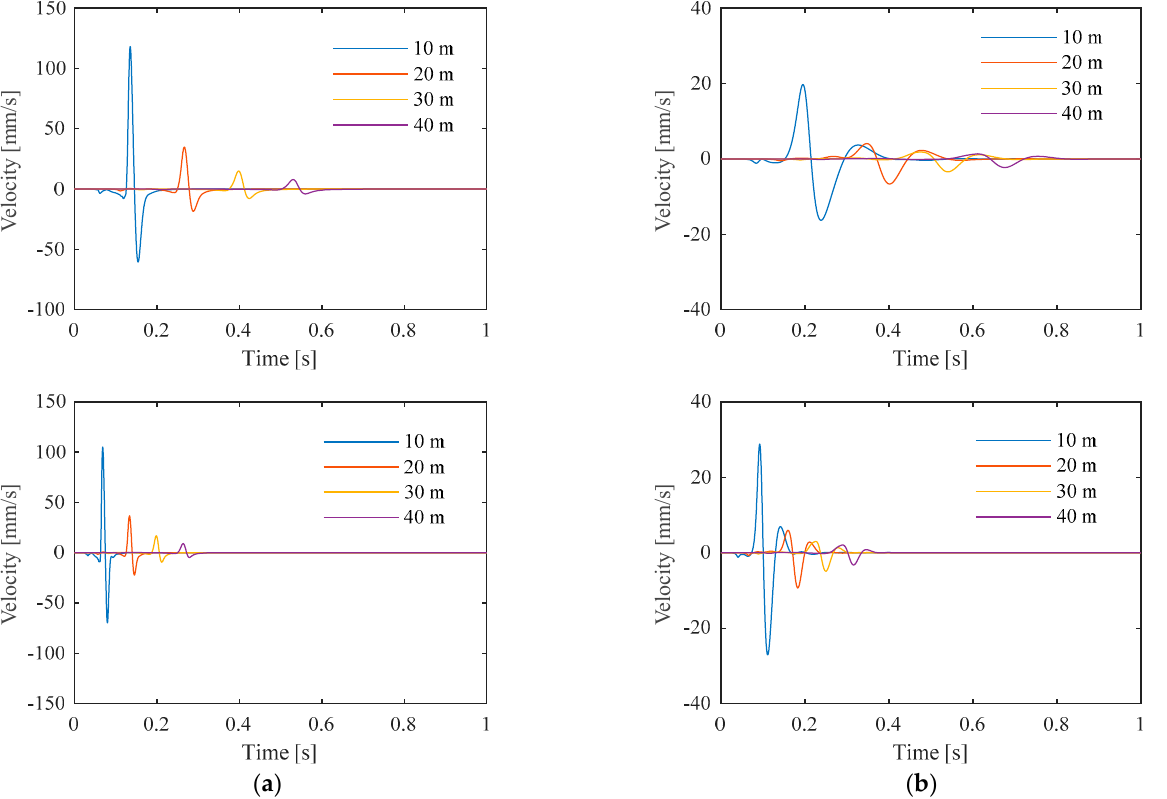
Figure 8. Vertical peak particle velocity record, in the time domain, for observation points at different distances from the source: ( a ) linear; ( b ) equivalent linear (upper: Vs = 80 m/s—Case 1; bottom: Vs = 160 m/s—Case 3).